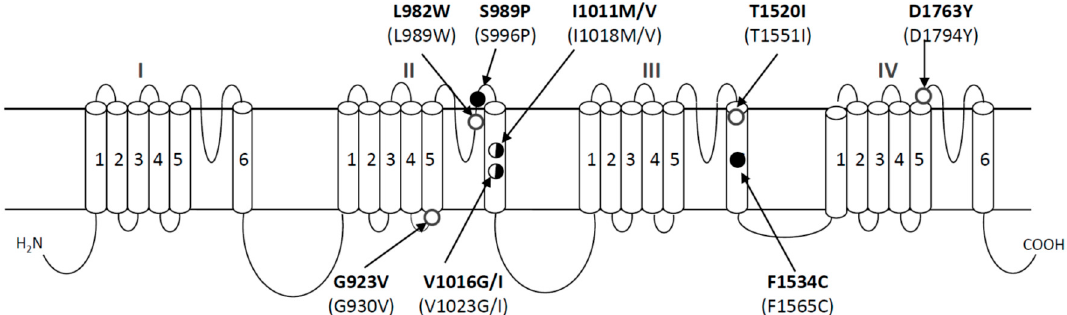
Figure 2. Mutations in the sodium channel protein that are associated with pyrethroid resistance in Aedes aegypti . Solid circles denote the mutations that have been functionally confirmed in Xenopus oocytes, half-solid circles indicate one of the substitutions has been confirmed in oocytes, and empty circles indicate the mutations that have not been confirmed or examined in oocytes. Amino acid positions of mutations are numbered based on the house fly sodium channel protein, Vssc1 (Genbank accession number: AAB47604). The numbers of the corresponding positions in AaNa v (Genbank accession number: EU399181) are indicated in parenthesis.